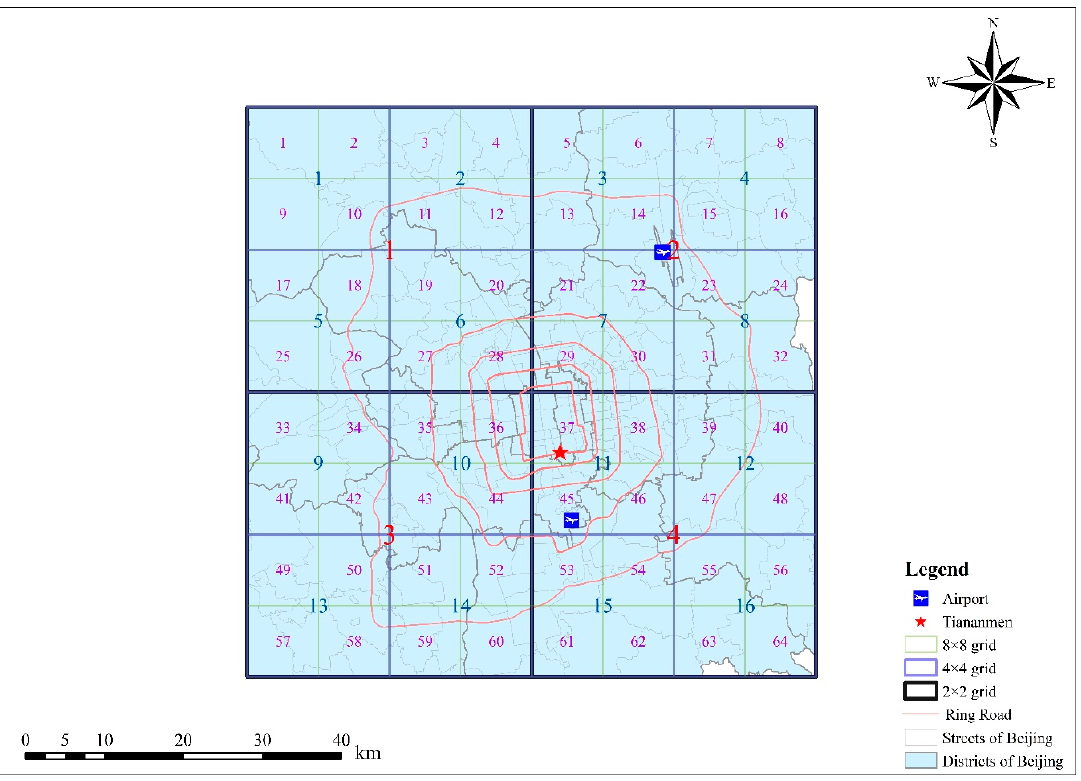
Figure 15. Division of space region in Beijing.